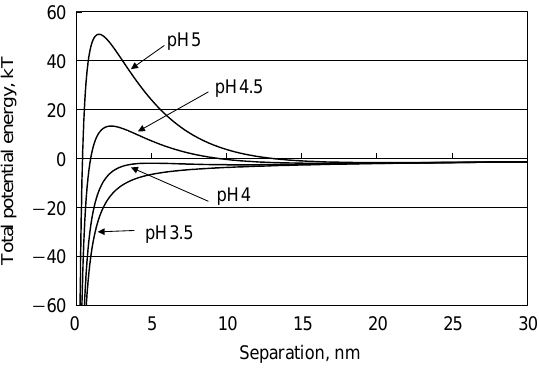
Total potential energy curves between 300nm silica and FS system as a function of separation distance. The curves from top to bottom are for pH5, 4.5, 4, 3.5, in that